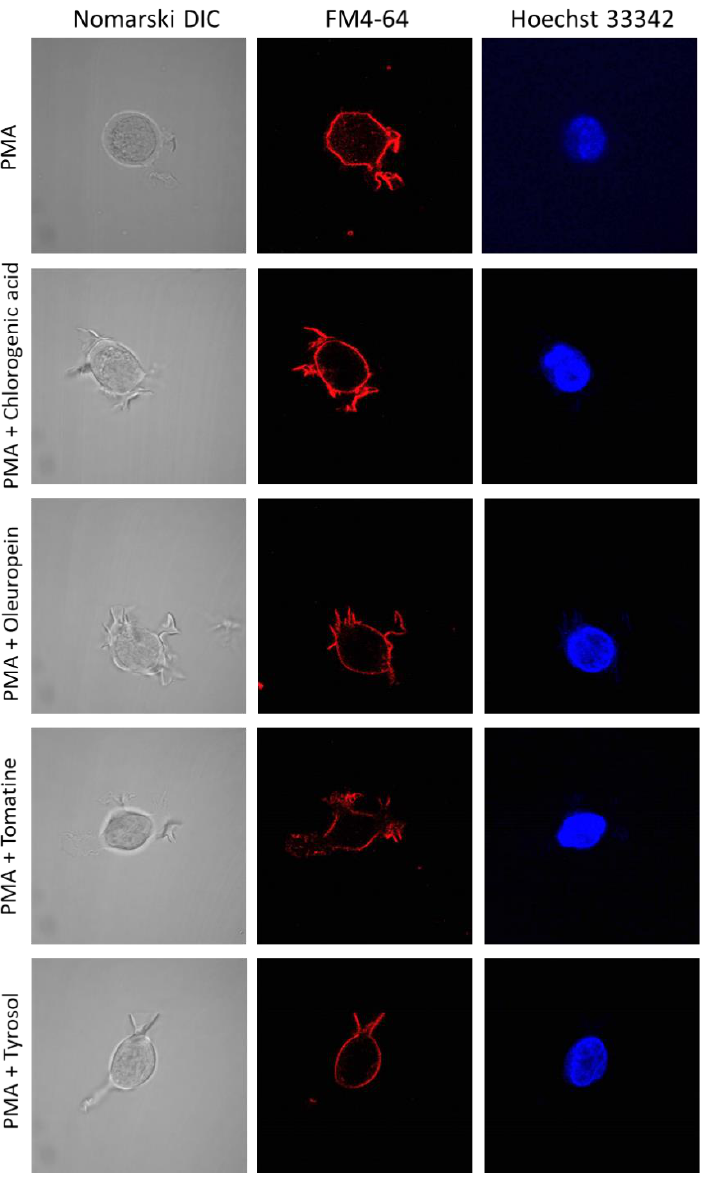
Figure 5. Double staining using Hoechst 33342 and FM4-64 in 72 h differentiated U-937 cells and in the presence of either of the bioactive compounds (chlorogenic acid, oleuropein, α -tomatine, and tyrosol, 10 µ M). The staining was performed for 5 min, and images (magnification 1000 × ) were taken in different channels (from left to right are Nomarski DIC, FM4-64 and Hoechst 33342).